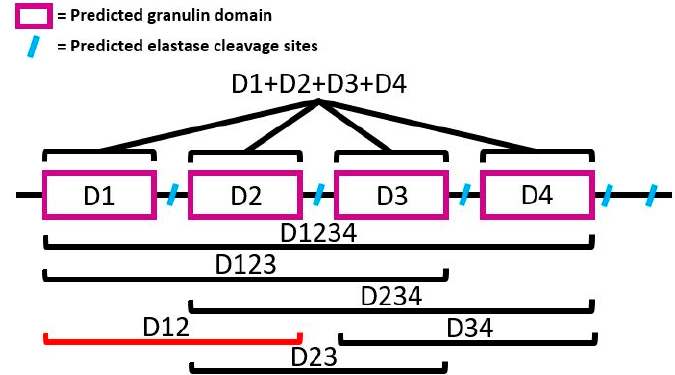
Figure 1. Diagram depicting the basic structure of Biomphalaria glabrata pro-granulin (BgGRN), the possible intermediate forms, as well as the fact that it can be cleaved into individual subunits. All generated granulin subunits feature a black bracket, whereas a red bracket indicates an intermediate that was not successfully cloned.